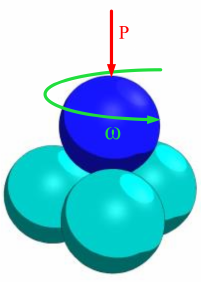
Figure 1. Schematic diagram of four-ball machine. Table 1. Parameters of four-ball friction